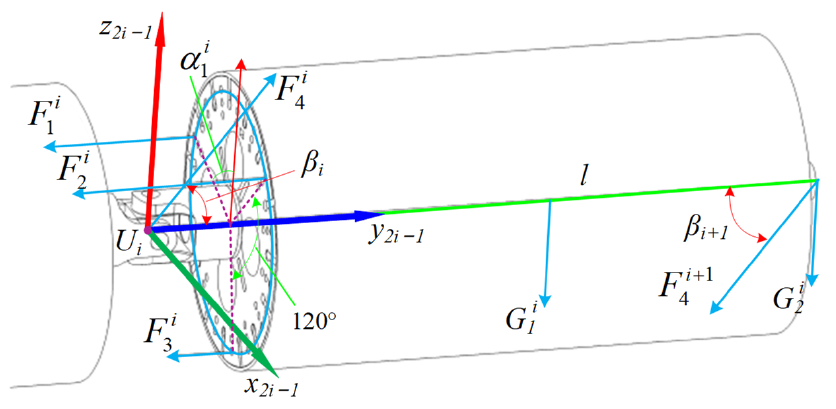
Figure 4. Force analysis of any joint i balance state.